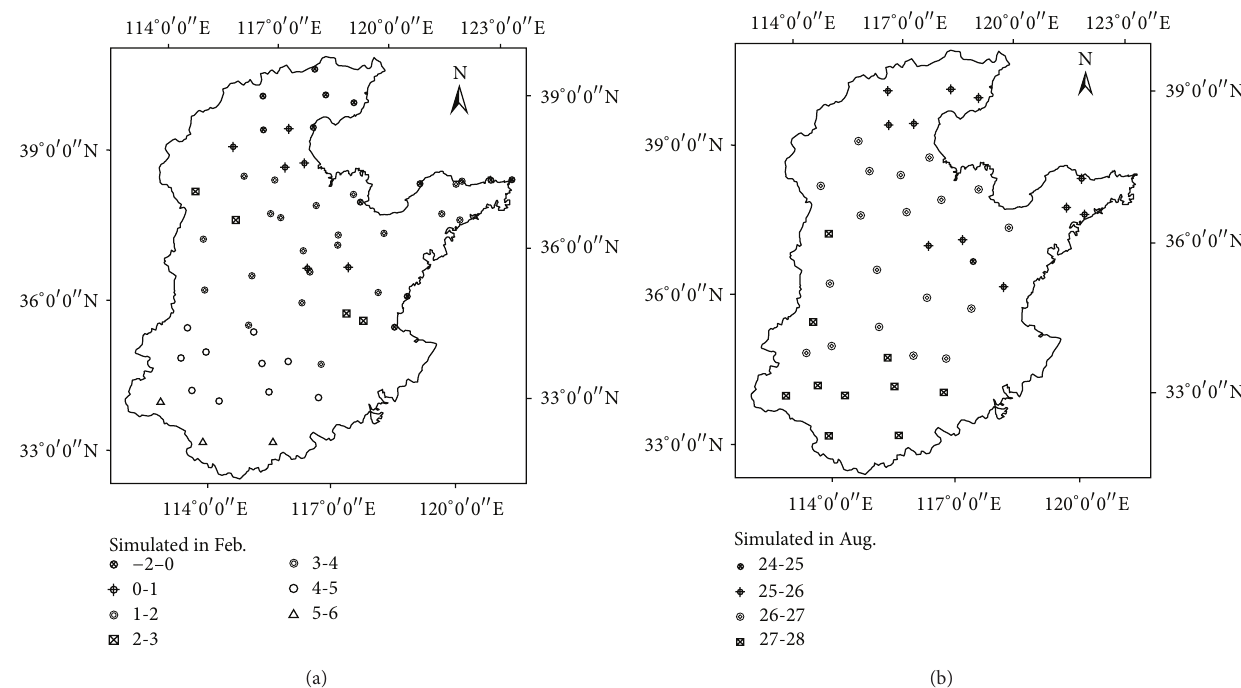
Figure 5: Simulated value of the daily average temperature in the North China Plain in February and August.